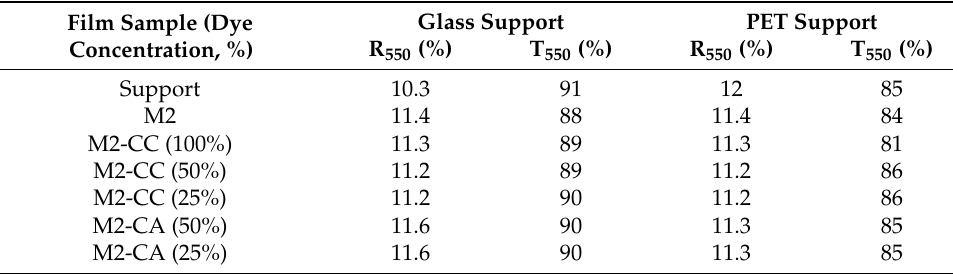
Figure 9. UV-Vis transmission spectra of M2 type hybrid coatings with dyes at variable concentrations deposited on glass ( a )/PET ( b ) supports. Table 3. UV-Vis reflectance and transmittance at 550 nm for the films with different dyes concentration, deposited on glass/PET support.